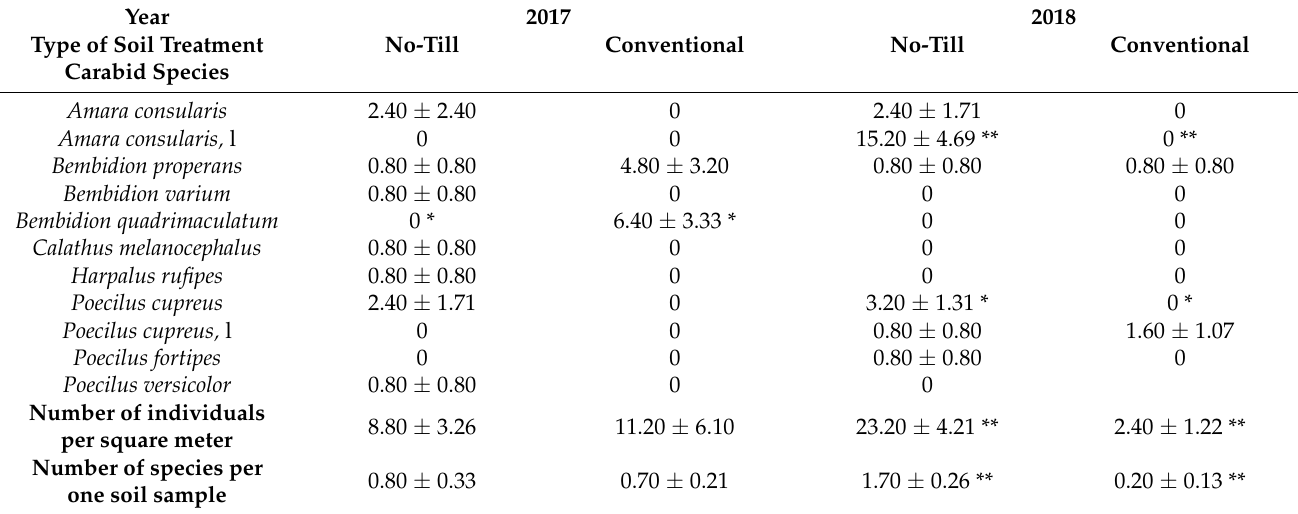
Table 5. Mean numbers and standard errors of the abundance of ground beetles (Coleoptera, Cara- bidae) per square meter (for number of species, per one soil sample) depending on the type of tillage (conventional or